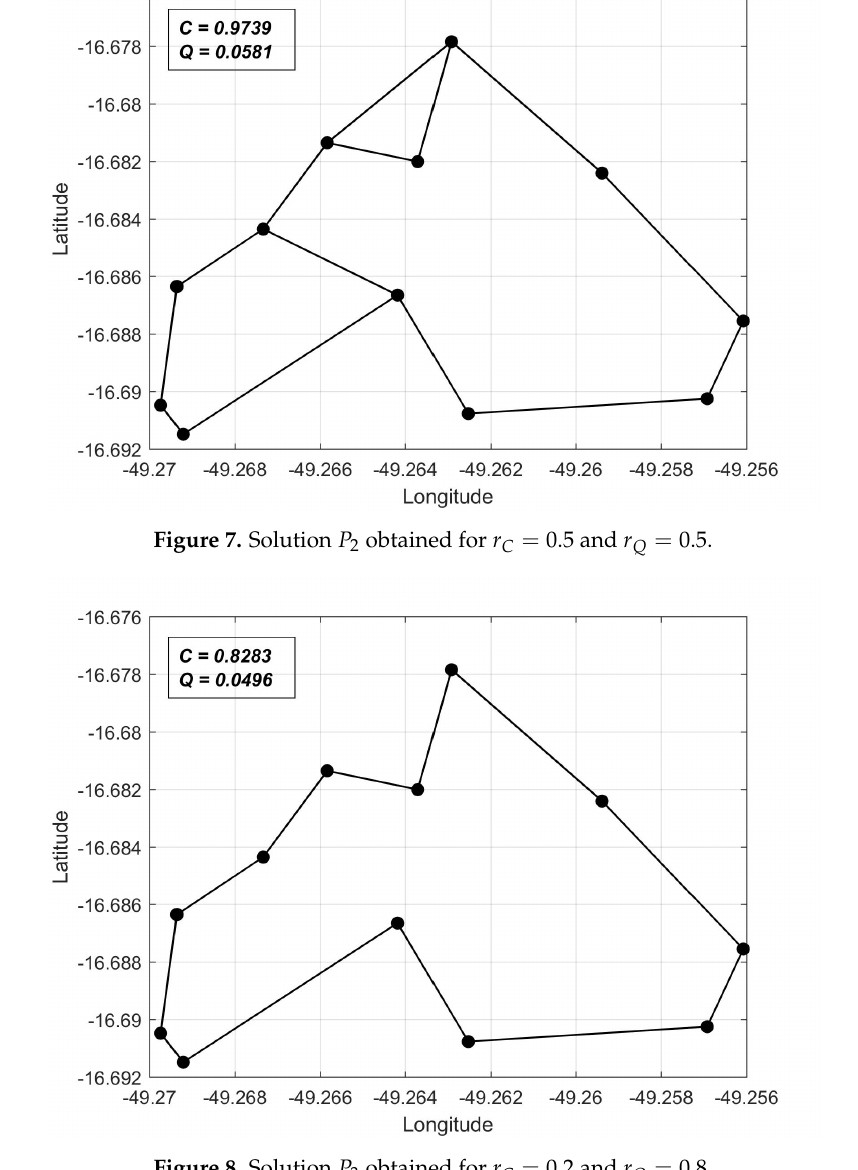
Figure 8. Solution P 3 obtained for r C = 0.2 and r Q =